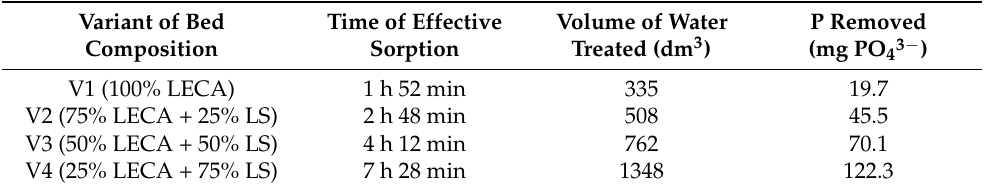
Figure 2. Orthophosphate (OP) removal from the hypolimnetic water during treatment on column beds (LS: limestone); dashed lines were used for better visibility of the trend. Results were presented for the time of effective sorption (OP removal rate of ≥ 10 ± 1%). Table 3. Parameters of the orthophosphate (OP) removal onto LECA/LS beds (effective sorption defined as a OP removal rate of ≥ 10 ±